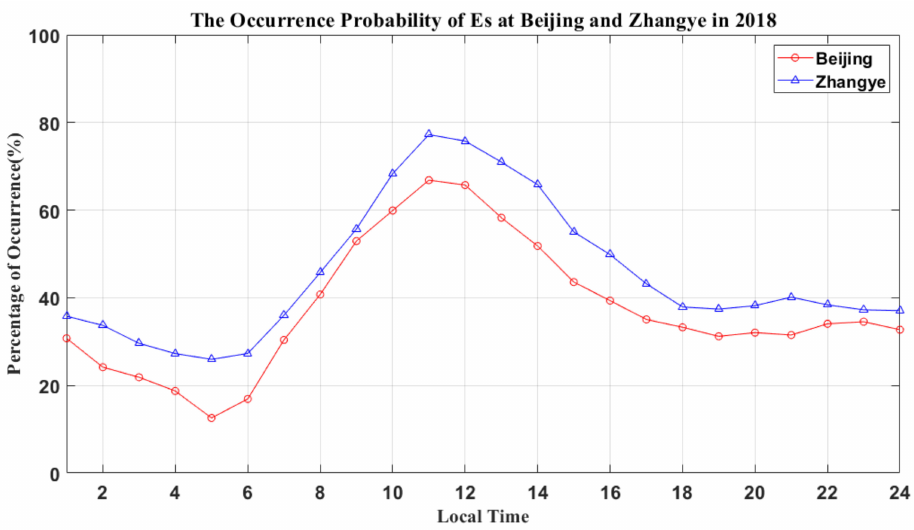
Figure 3. Diurnal variations in the occurrence probability of the Es layer at Beijing and Zhangye stations.